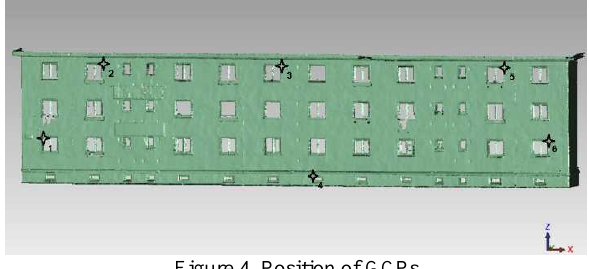
Figure 4. Position of GCPs 5.3.3